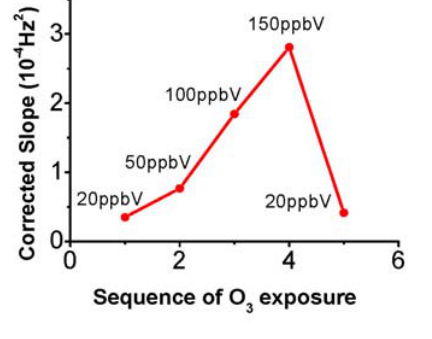
Figure 5. Ozone measurements performed with a single QTF ozone sensor with ozone exposure events equivalent to increasing and decreasing ozone levels observed along a